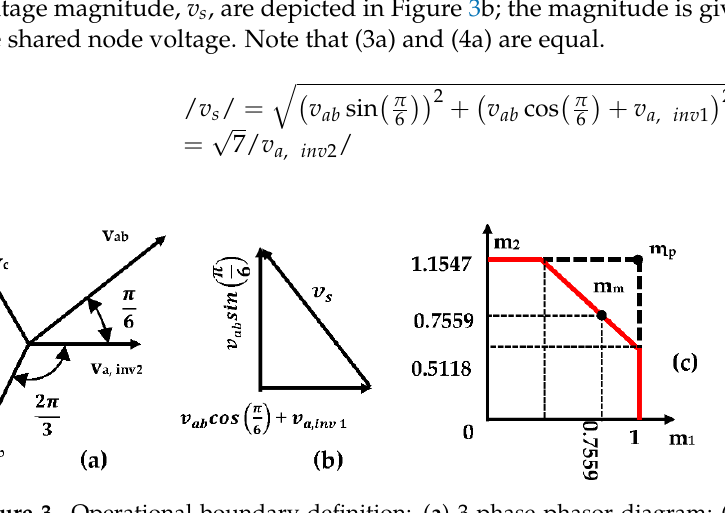
Figure 3. Operational boundary definition: ( a ) 3-phase phasor diagram; ( b ) components of the system’s voltage magnitude, v s ; ( c ) boundaries of the different and common frequency modes of oper- ation.